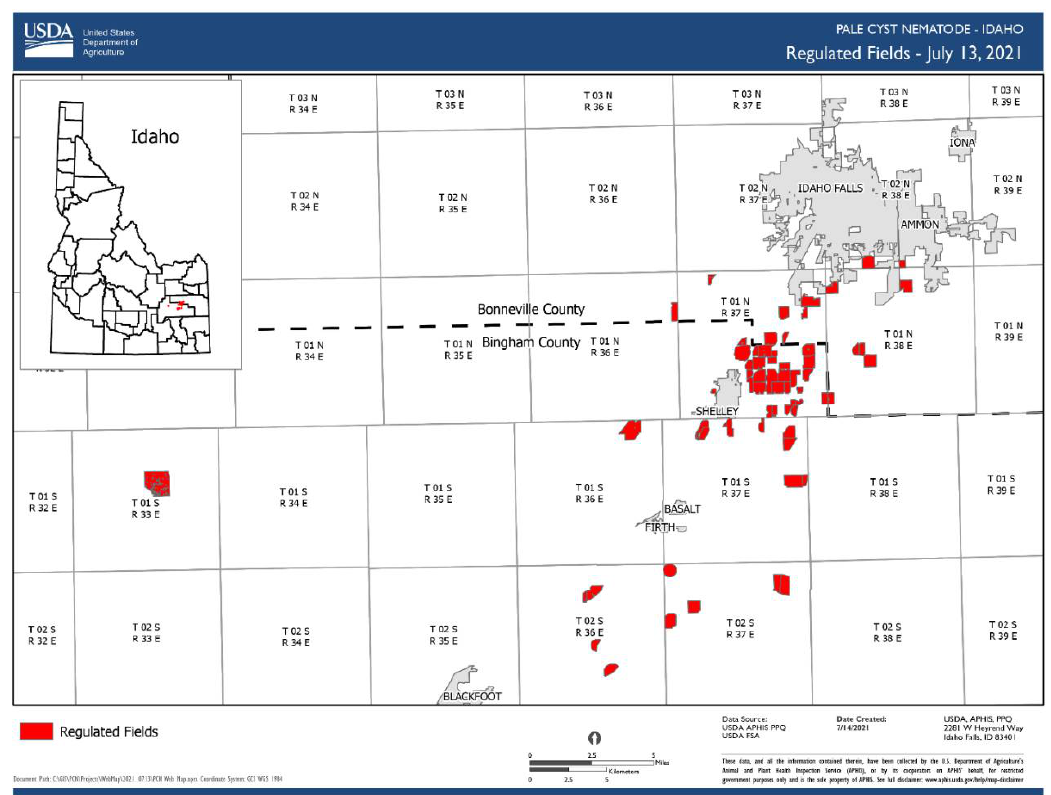
Horticulturae 2022 , 8 , x FOR PEER REVIEW Figure 3. Distribution of Globodera pallida in the U.S. (source, USDA, APHIS). Figure 3. Distribution of Globodera pallida in the U.S. (source, USDA, APHIS).